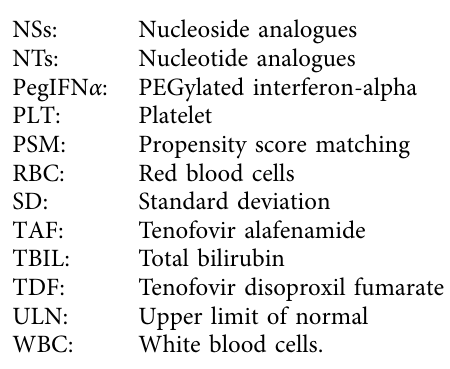
Table S1: baseline characteristics in the HBeAg-positive subgroup. Table S2: baseline characteristics in the HBeAg- negative subgroup. Table S3: baseline characteristics in the “add-on” subgroup. Table S4: baseline characteristics in the “NAs-experienced” subgroup. Table S5: baseline charac- teristics of patients with diferent HBeAg status. Table S6: baseline characteristics of patients with diferent combina- tion strategies. Table S7: efcacy results at week 48 in the HBeAg-positive subgroup. Table S8: efcacy results at week 48 in the HBeAg-negative subgroup. Table S9: efcacy results at week 48 in the “add-on” subgroup. Table S10: